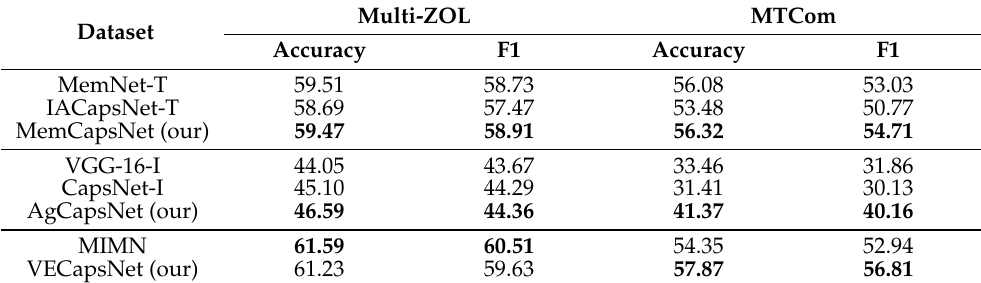
Table 5. The metrics of accuracy and F1-score on the multimodal